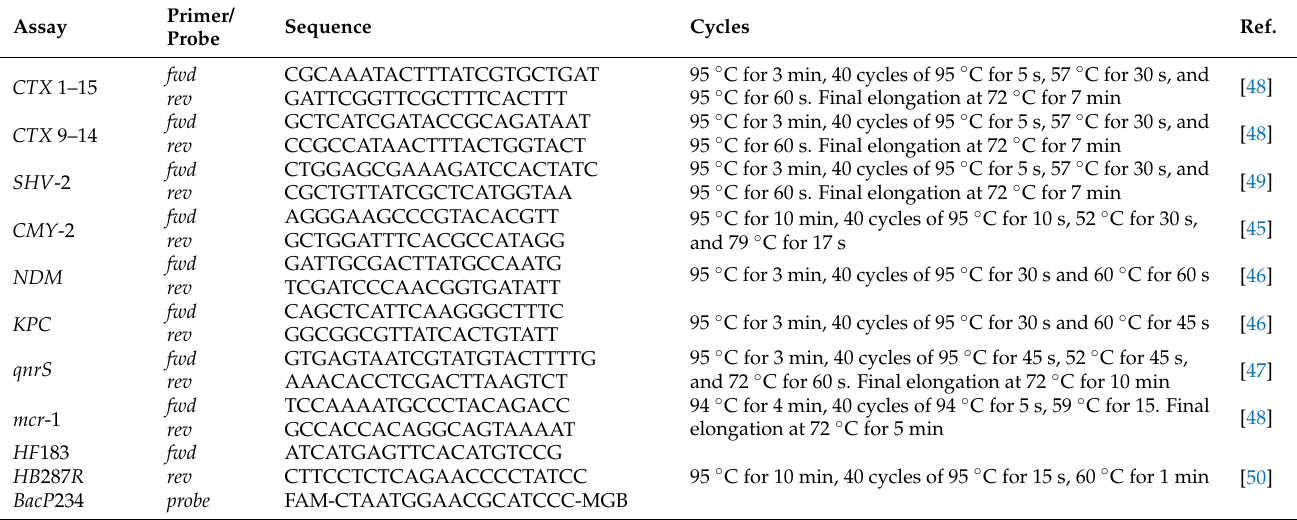
Table 4. Primer and probe sequences and cycling conditions for qPCR